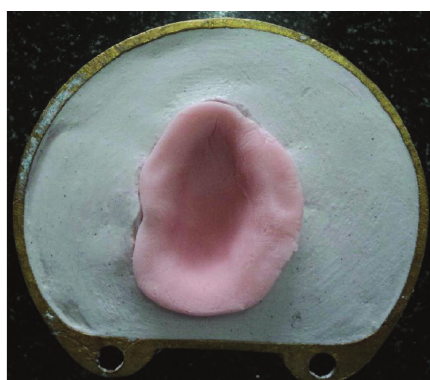
Figure 8: Packing with heat-cured PMMA.